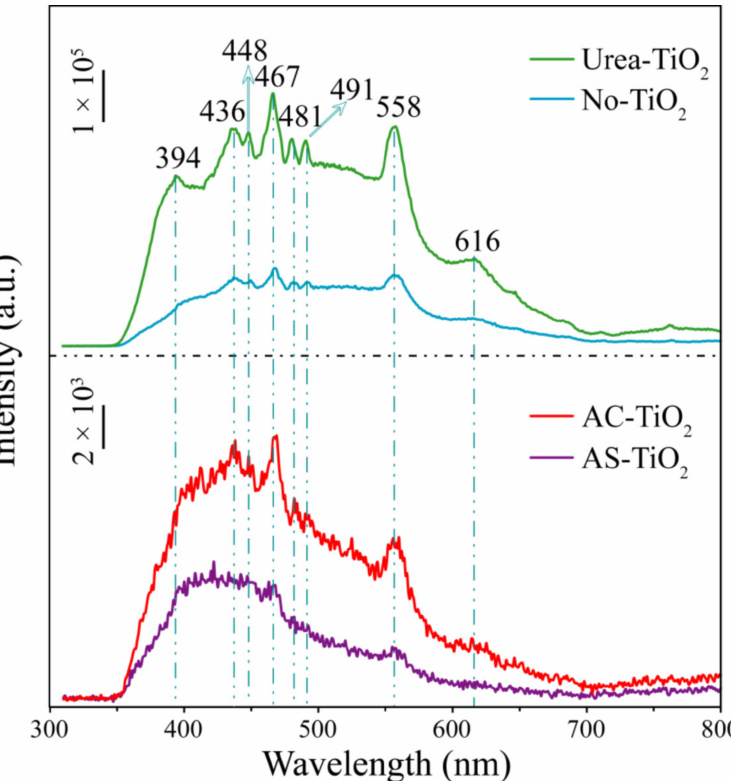
Figure 5. PL emission spectra (excited at 325 nm) of the prepared AC-TiO 2 , AS-TiO 2 , urea-TiO 2 , and No-TiO 2